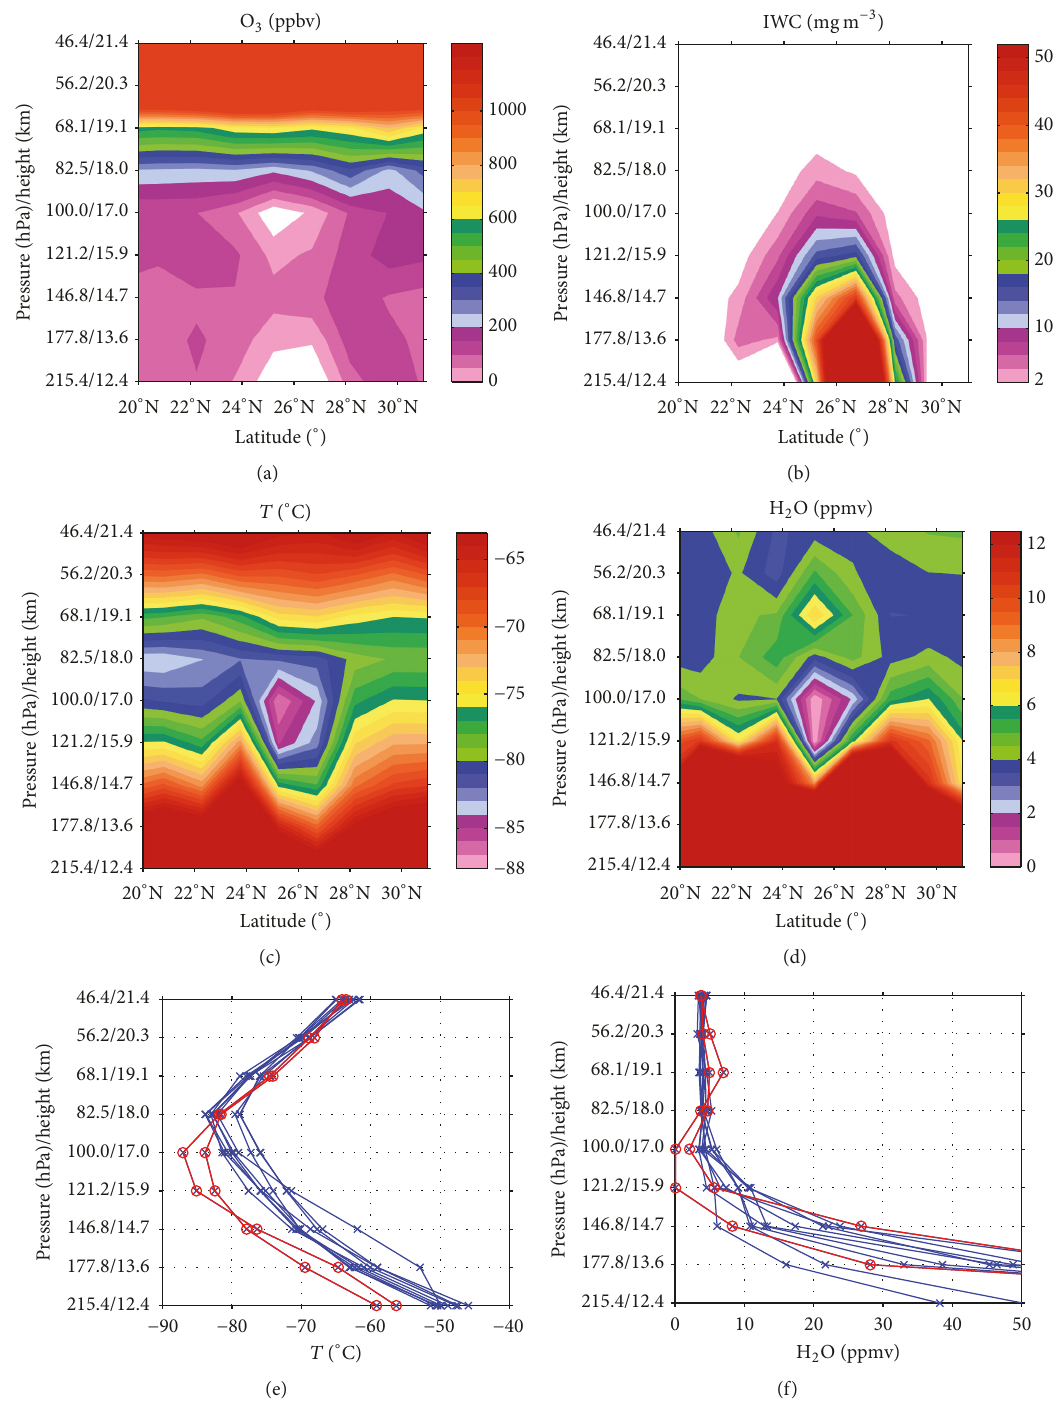
Figure 3: Cross-sections of the MLS results along the thick red line in Figure 2(a). (a) Ozone volume mixing ratio (ppbv); (b) IWC (mg ⋅ m −3 ); (c) temperature ( ∘ C); (d) water vapor content (ppmv); (e) profiles of temperature inside (two red curves) and outside (eight blue curves) the MCC; and (f) profiles of water vapor content inside (two red curves) and outside (eight blue curves) the